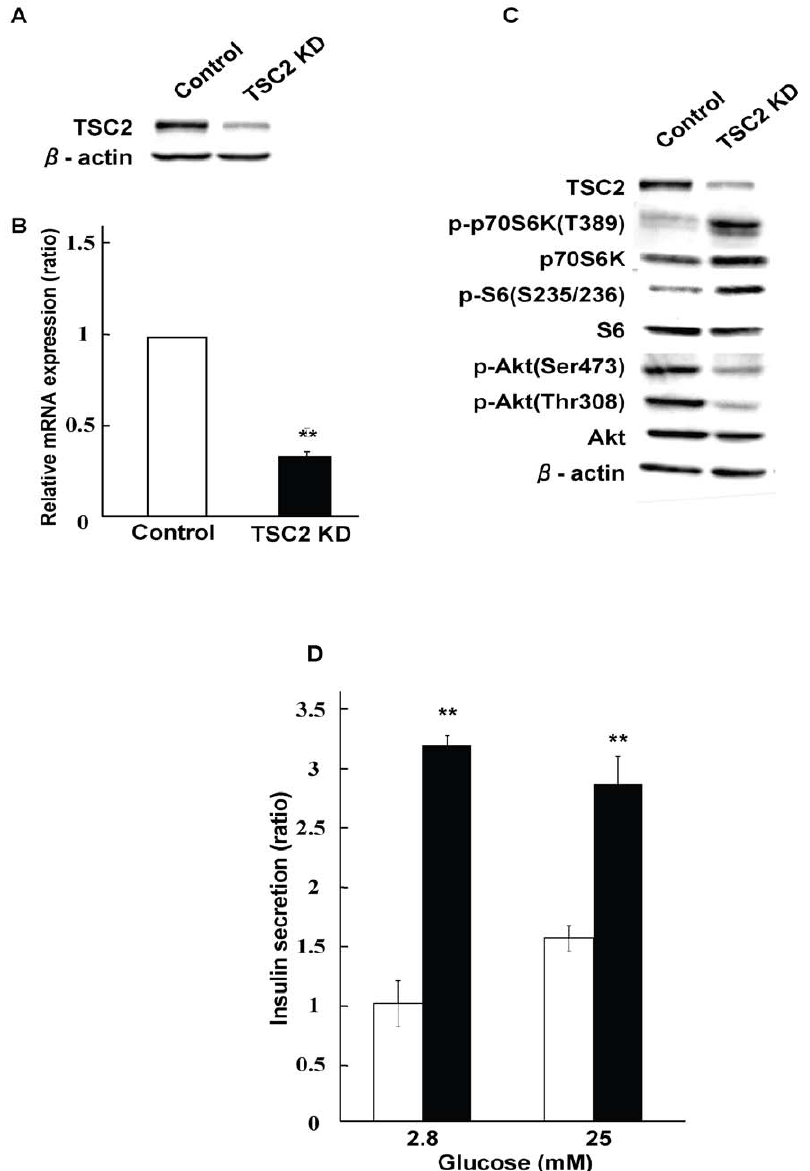
Figure 3. Establishment of TSC2 knockdown INS-1 cells. ( A , B and C ) INS-1 cells treated with scramble siRNA (control) and TSC2 siRNA ( D TSC2) were lysed and subjected to immunoblot analysis with antibodies against TSC2 ( A ) or the indicated proteins ( C ), or subjected to real-time PCR analysis of Tsc2 mRNA ( B ). Data in B are relative expression values for INS-1 cells treated with scramble siRNA (control) and are means 6 SE from four independent experiments. ** P , 0.01 ( D ) Insulin secretion in response to the indicated concentrations of glucose for 30 min was assessed in INS-1 cells and expressed per DNA content. Data were obtained from four independent experiments.